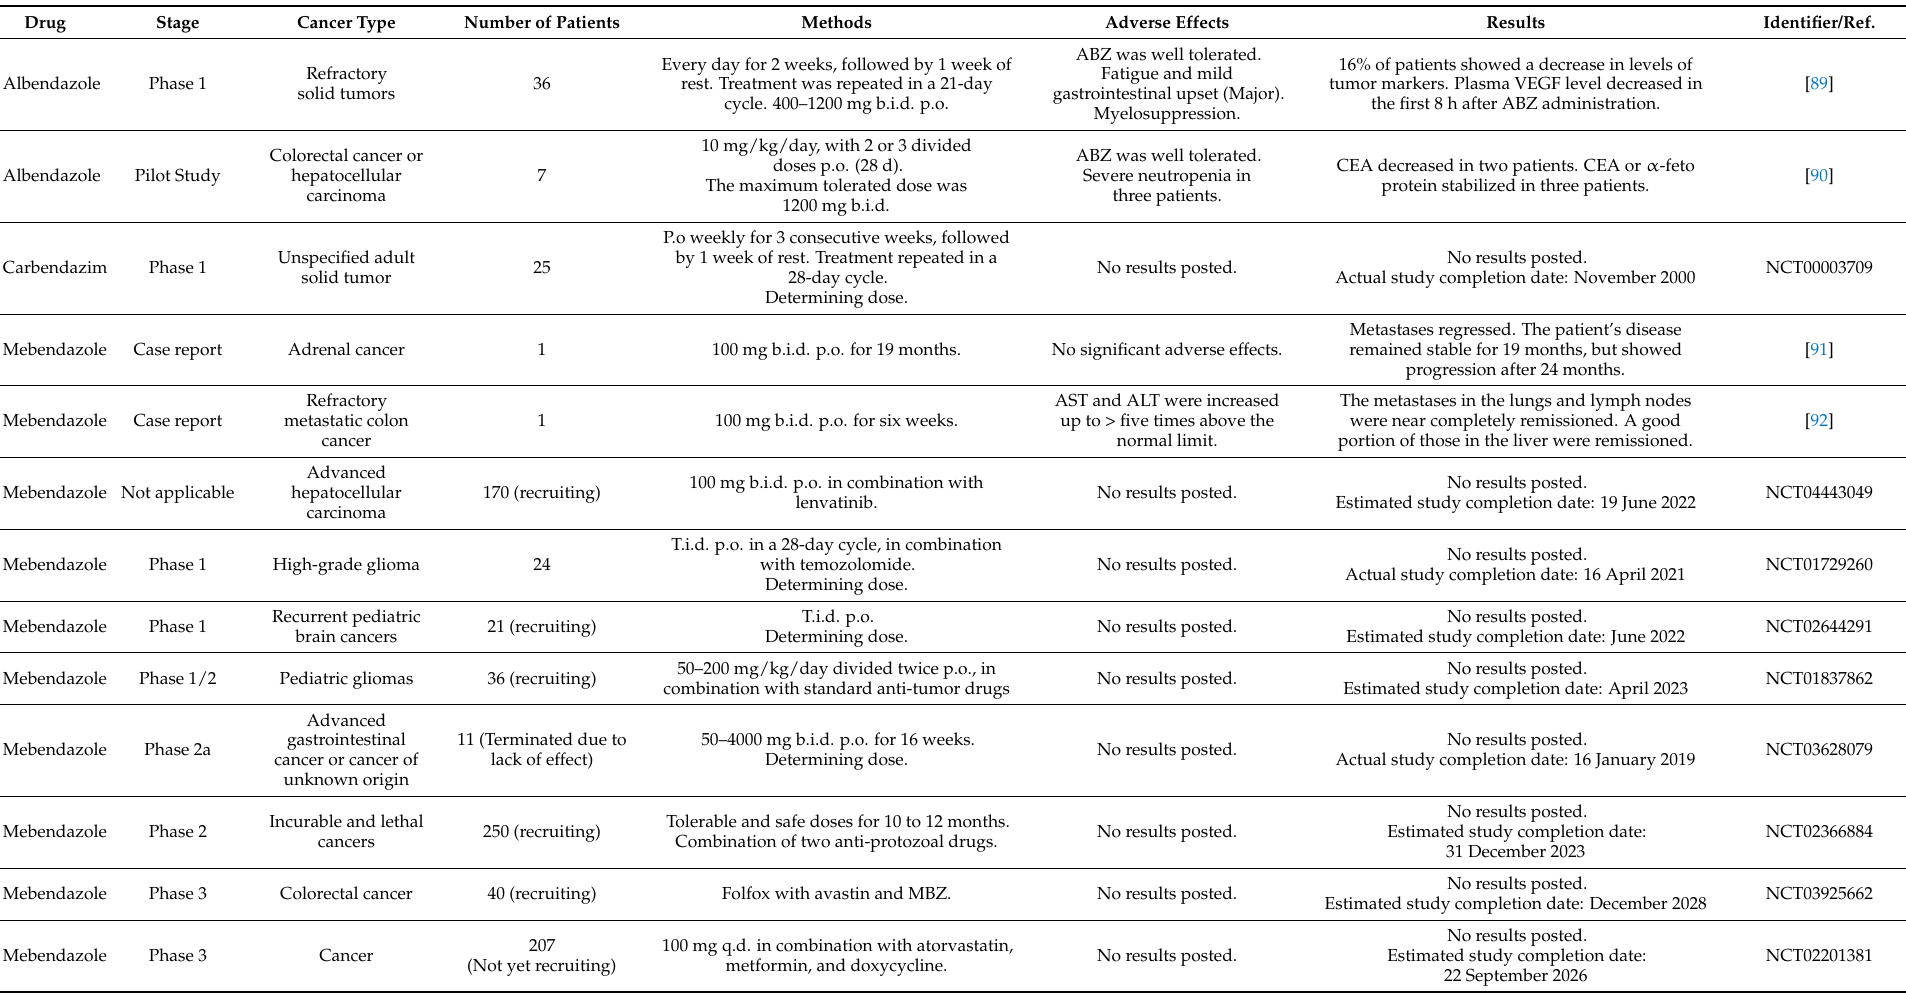
Table 2. Clinical Evidence of Benzimidazoles for Anti-tumor